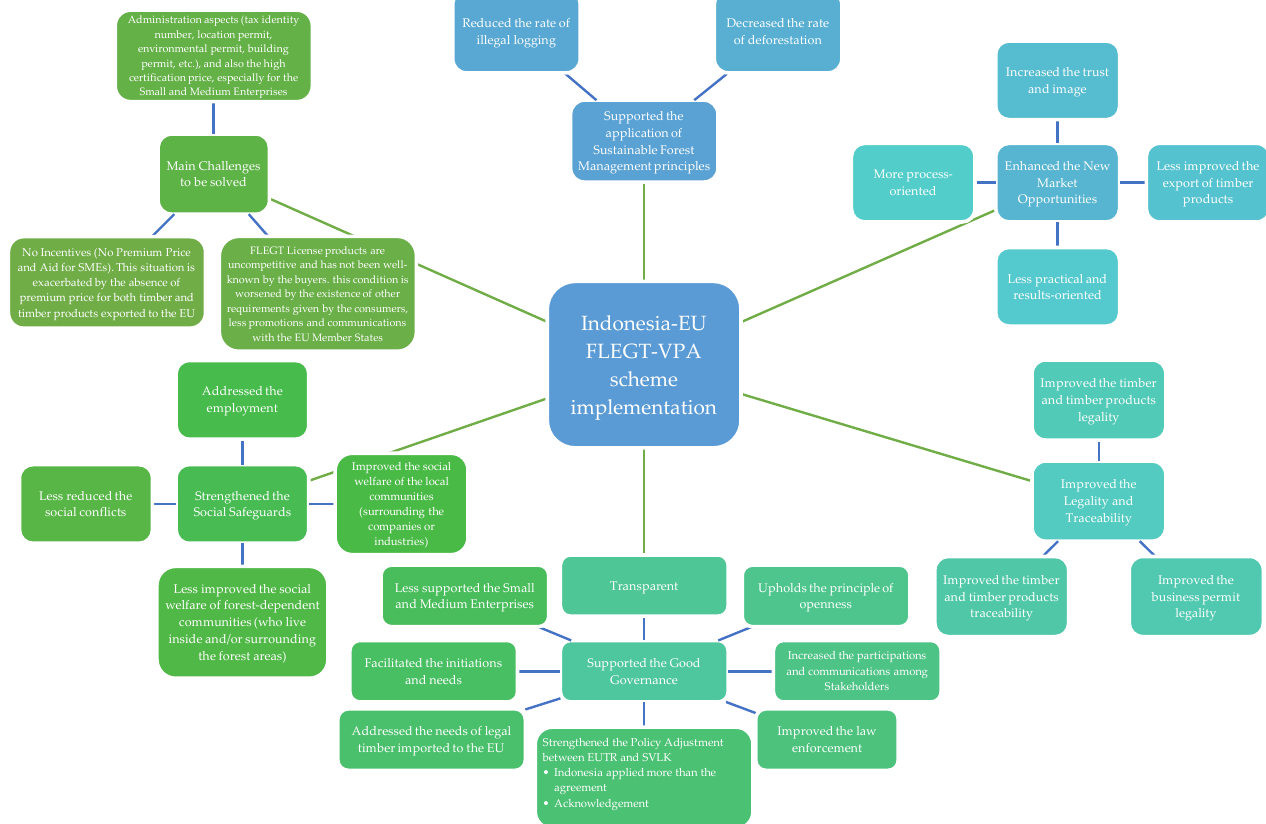
Figure 3. Key findings of the in-depth and focus group interviews results.